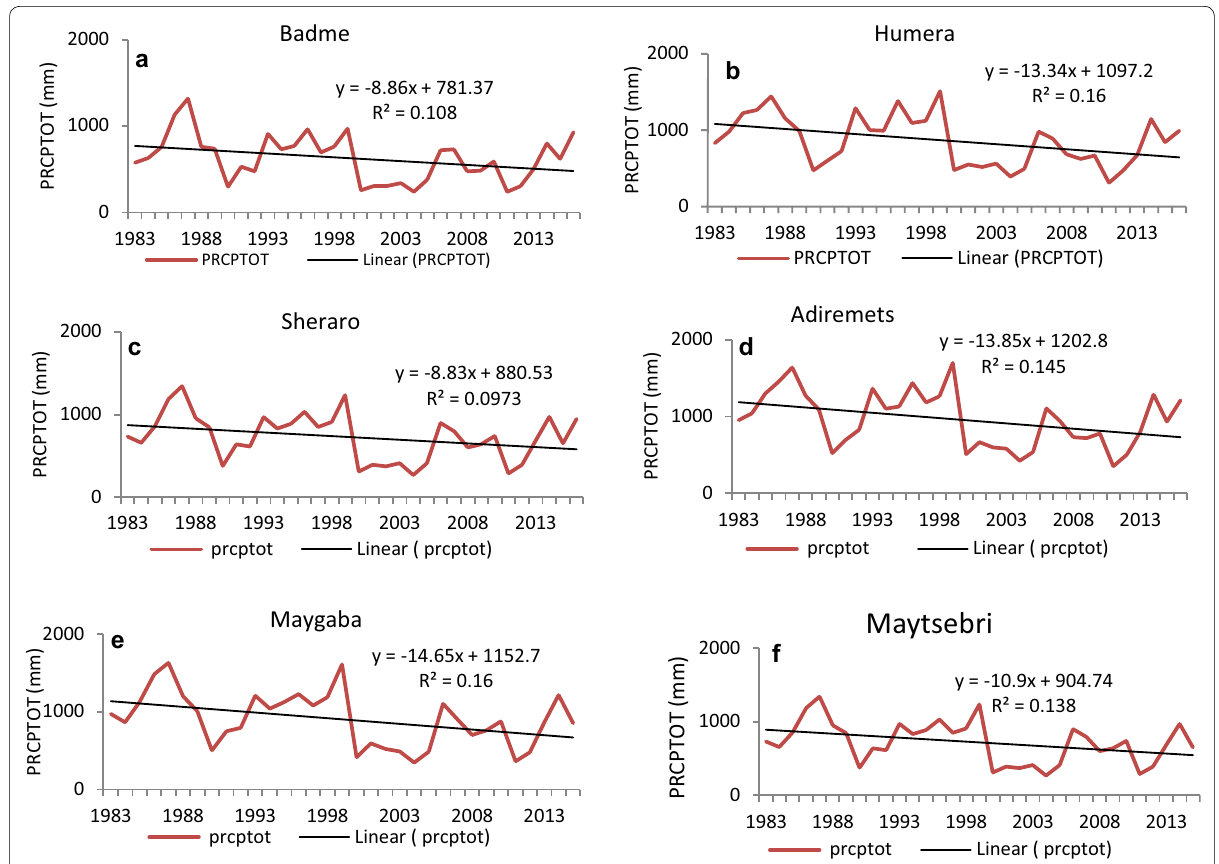
Fig. 12 Total annual precipitation (PRCPTOT) of a Badme, b Humera, c Sheraro, d Adiremets, e Maygaba, f